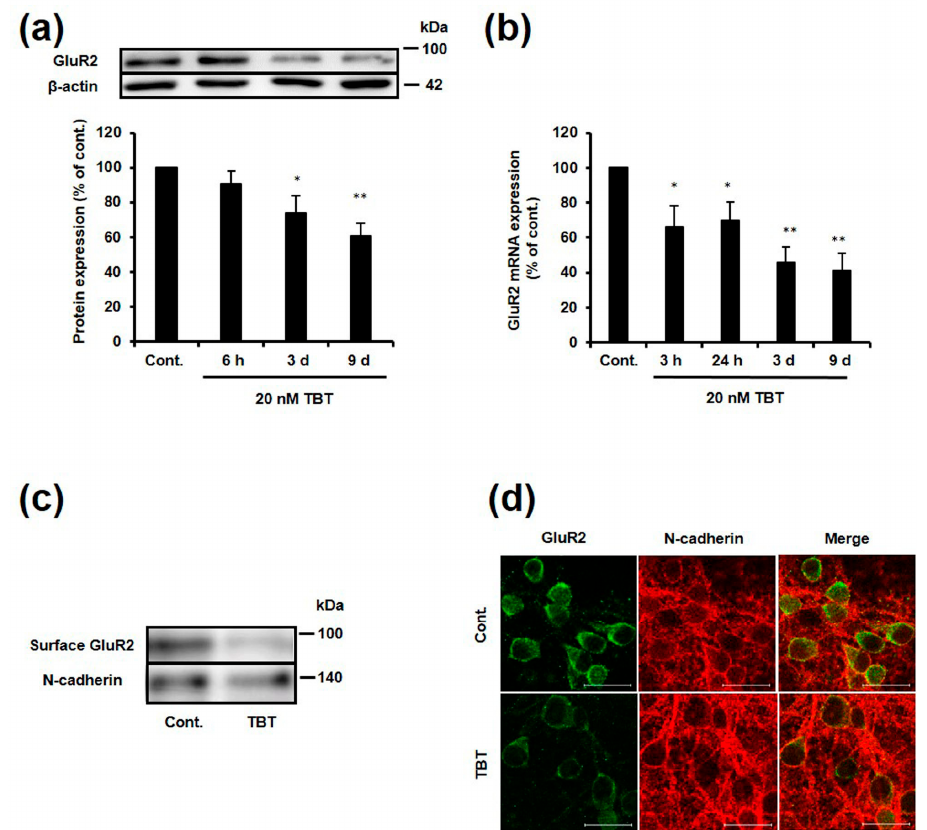
Figure 1. TBT-induced changes in GluR2 whole cell protein, mRNA, and membrane protein